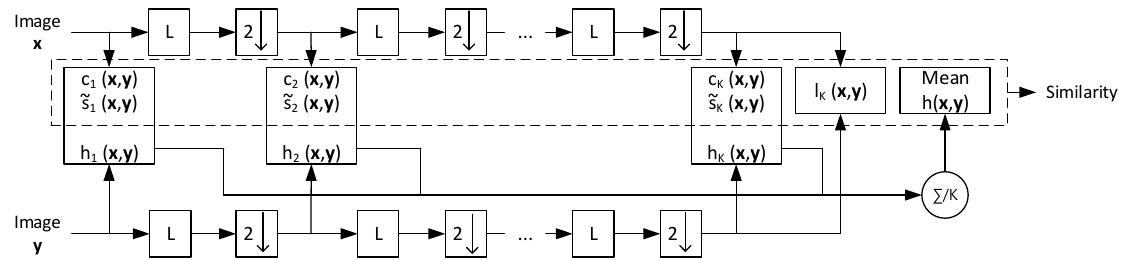
Figure 12. MS-ISSIM-S procedures to quantify the image quality (adapted from [71]). 𝐿 is low-pass filtering, and 2 ↓ denotes downsampling by 2 .